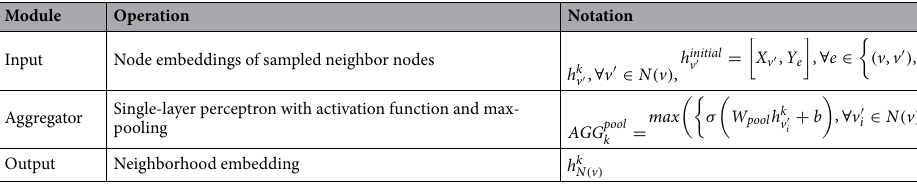
th ( ∀ k ∈ 1, . . . , K ) Table 1. The k aggregator